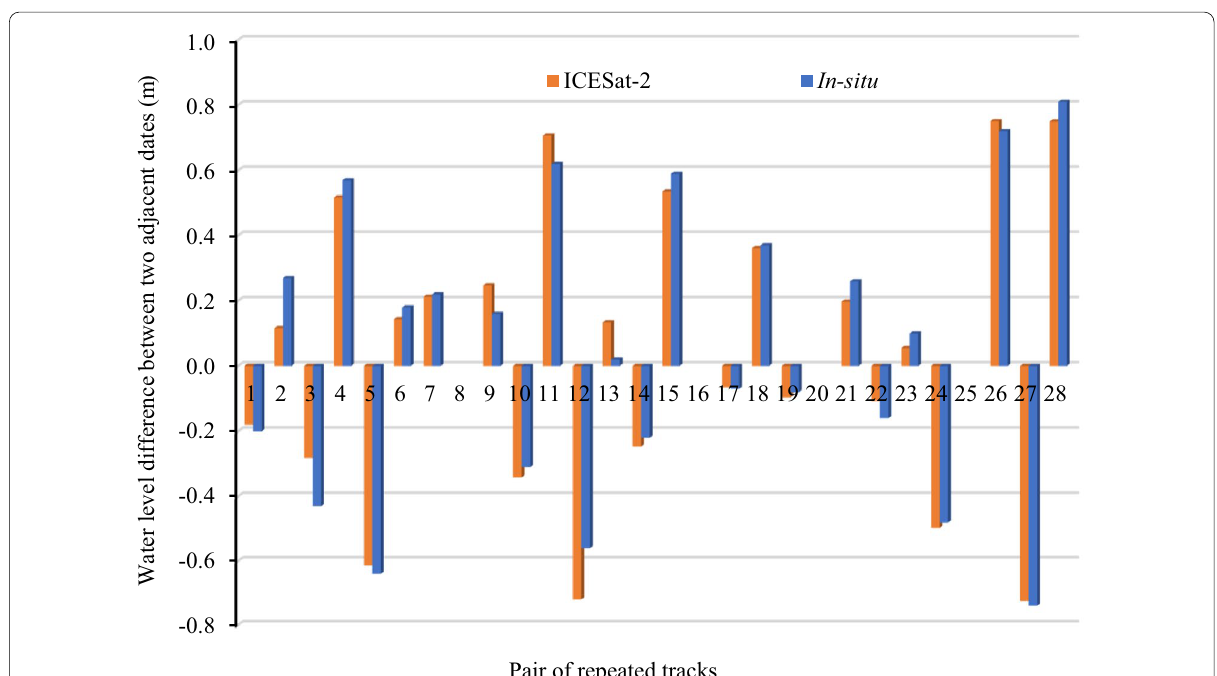
Fig. 4 The relative difference between two adjacent dates of repeated tracks and the corresponding in situ gauge data of Taihu Lake